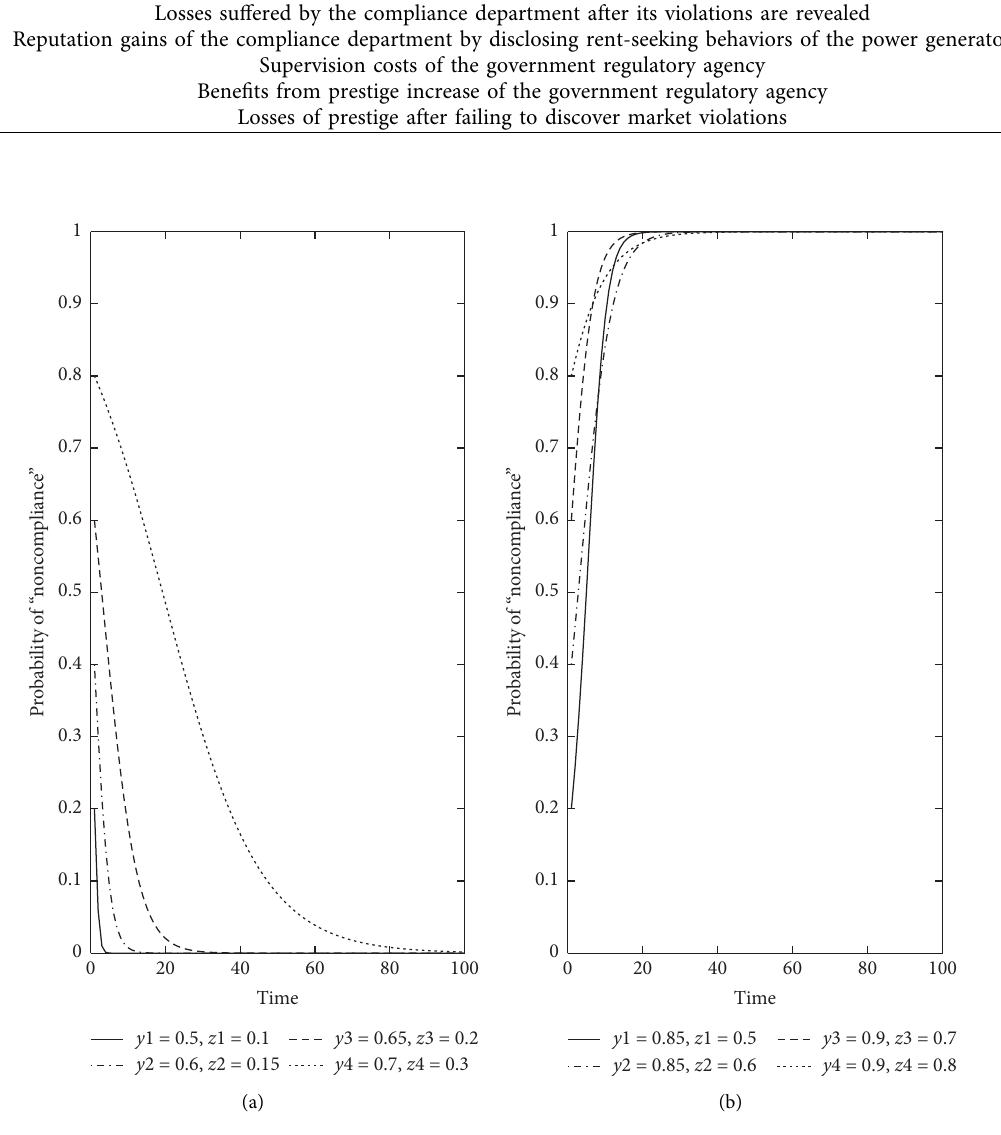
Figure 1: Evolutionary process of the power